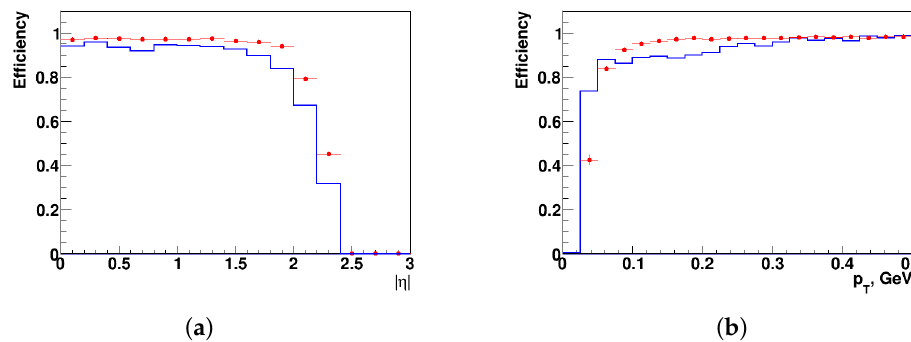
Figure 6. ( a ) Track reconstruction efficiency as a function of | η | for primary and secondary tracks. ( b ) Efficiency vs p T for primary and secondary tracks. Symbols and solid lines correspond to primary and secondary tracks, respectively.